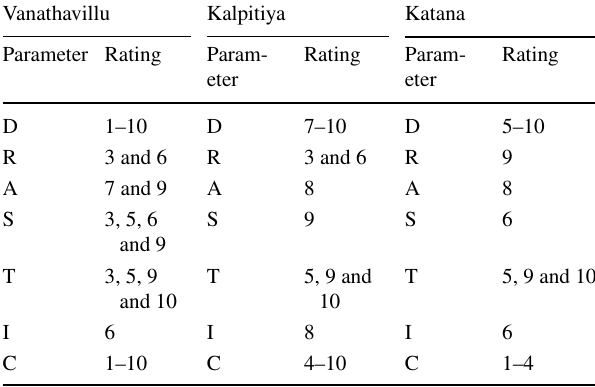
Table 2 Ratings of the DRASTIC parameters of the study areas with the assigned weight of 1–5